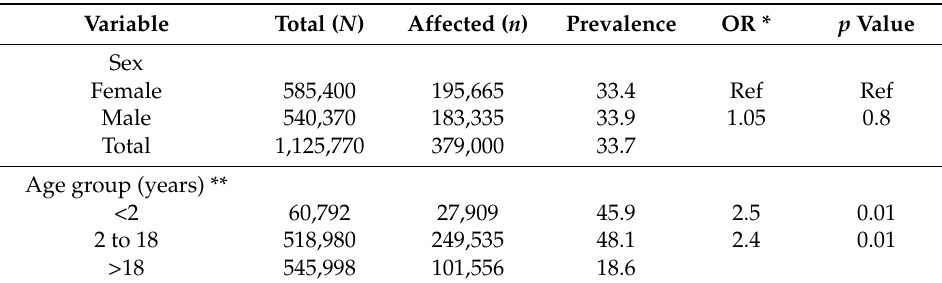
Figure 2. Scabies distribution in in Amhara Region, Ethiopia (2015–2016). Table 2. Prevalence of scabies and bivariate analysis of demographic factors based on a house-to-house census in Amhara Region, Ethiopia (October 2015).